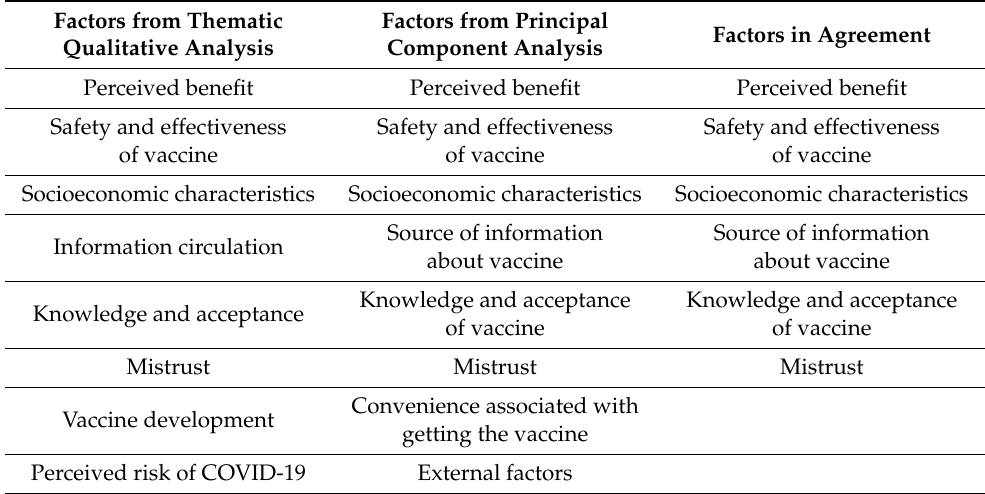
Table 5. Factors in agreement from thematic qualitative analysis and principal component